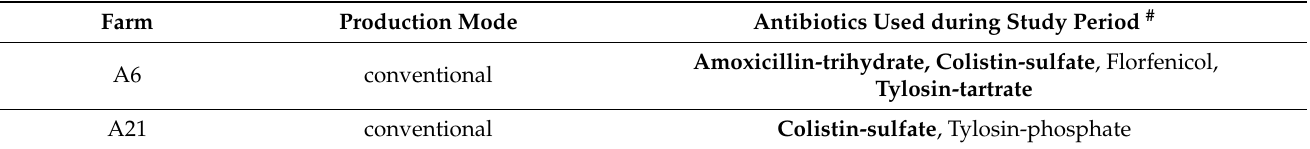
Table 8. Antibiotics applied at the respective farms during the study period: overview of all